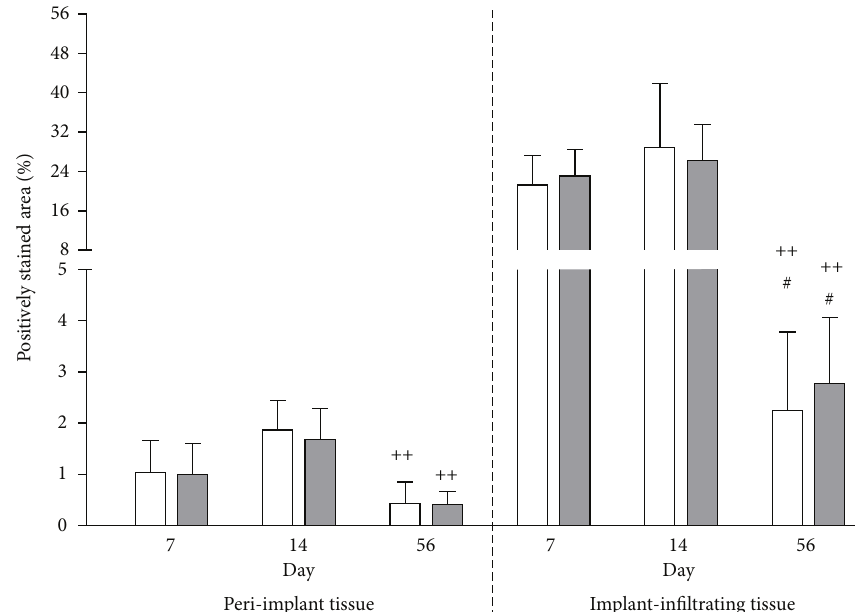
Figure10:LocalinflammatoryreactionmeasuredastissuesectionareapositivelystainedbyCD68-positivetotalmonocytesandmacrophages in the peri-implant tissue and implant-infiltrating tissue following i.m. implantation of untreated electrospun PLA meshes (white columns) or PPAAm-coated meshes (gray columns) after 7, 14, and 56 days in Lewis rats. Columns represent the mean and error bars represent the standard deviation of 8 rats per experimental day. Hash symbols (#) indicate a significant difference ( 𝑃 < 0.05 ) versus day 7, and plus symbols (+) indicate a significant difference ( 𝑃 < 0.01 ) versus day 14 (Wilcoxon rank-sum test).